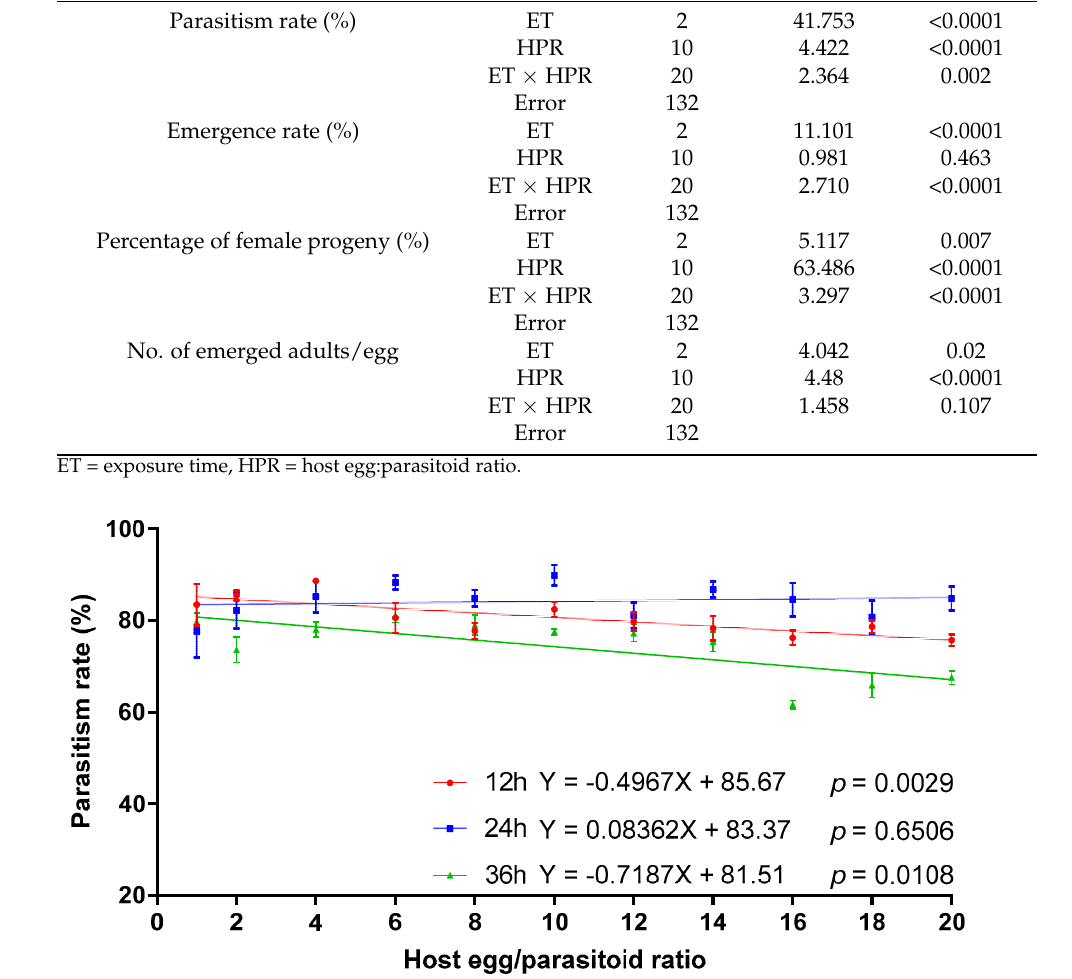
Figure 4. The effect of host egg:parasitoid ratio on parasitism rates of T. remus on S. litura eggs at different exposure times.